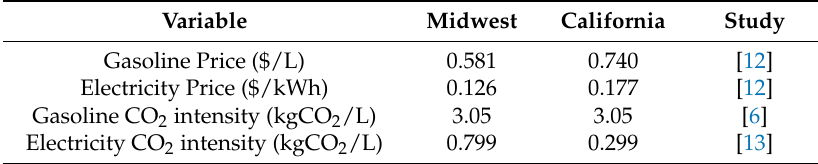
Table 2. Values for some vehicle variables in the Midwest and California,